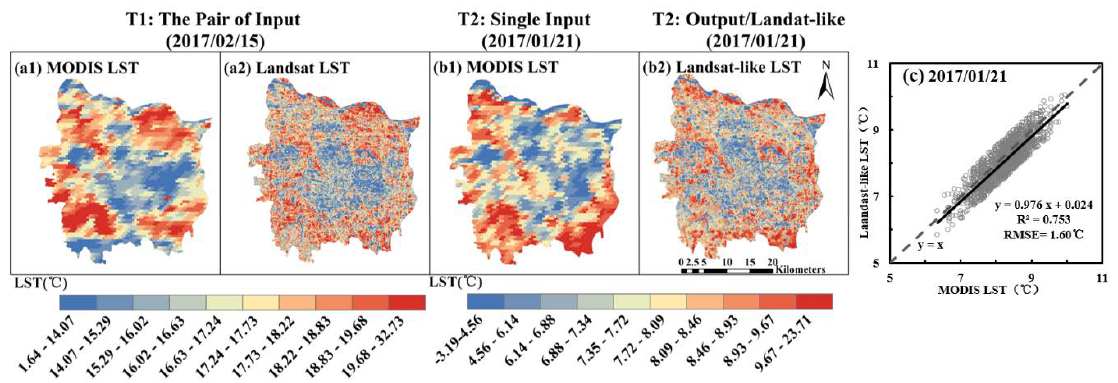
Figure 4. Input data for predicting “Landsat-like” LST in 21 January 2017 and accuracy assessment of the output.